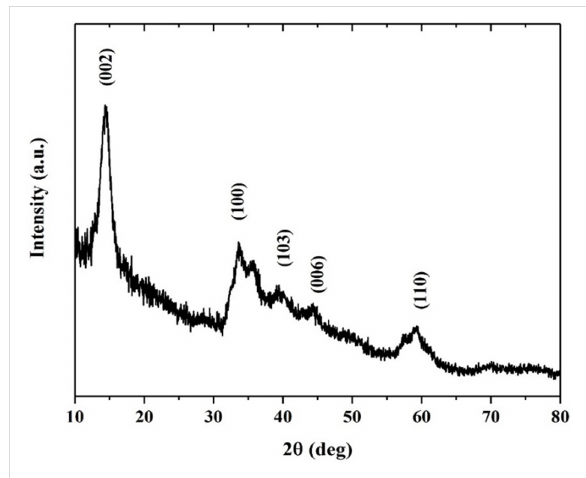
Figure 1: The X-ray diffraction pattern of flower-shaped MoS 2 nanoflakes synthesized by the hydrothermal